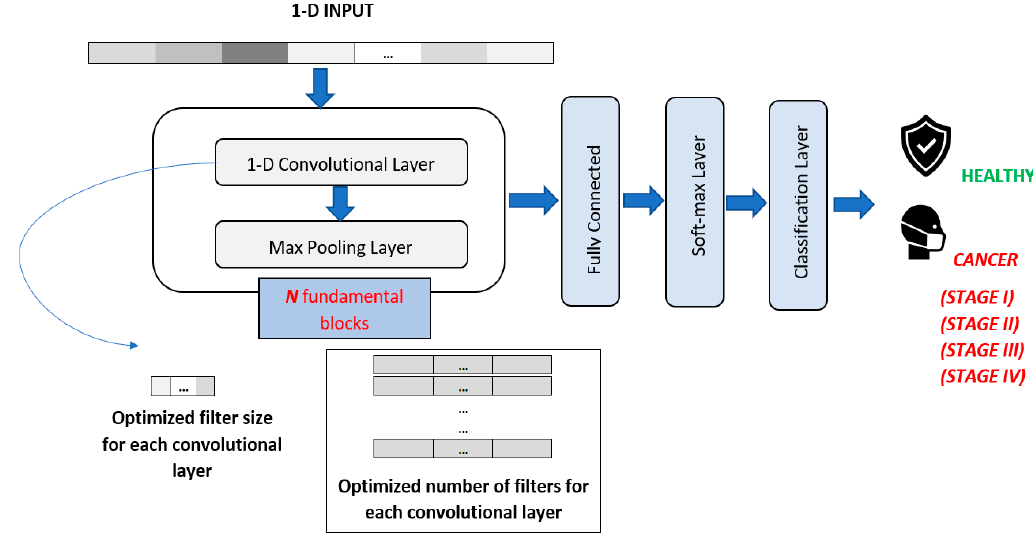
Figure 5. Proposed 1-D CNN architecture. (Illustrations by the authors).